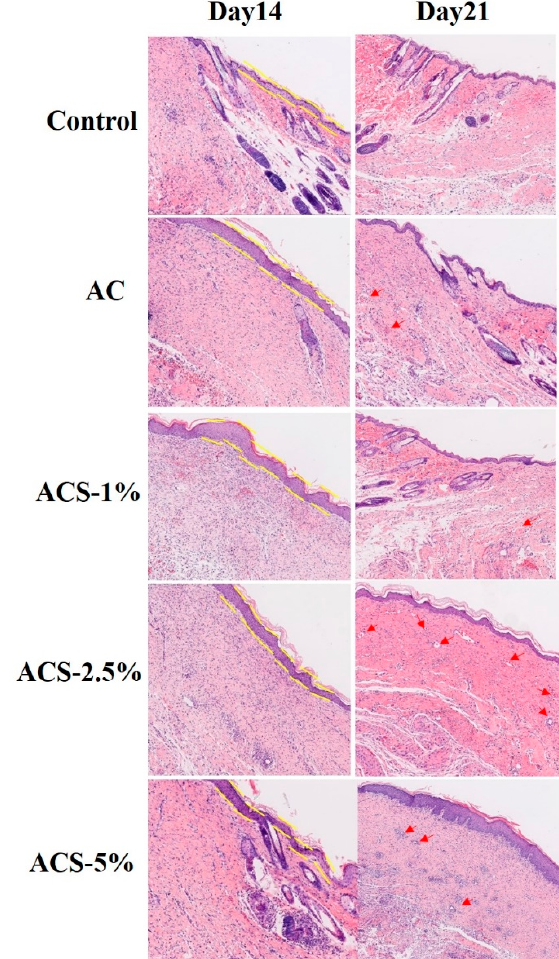
Figure 8. Regenerated skin tissues in wound sites after treatment with composite sponges at 14 days and 21 days as detected by H&E staining (epidermal thickness: yellow lines; blood vessels: red arrows).